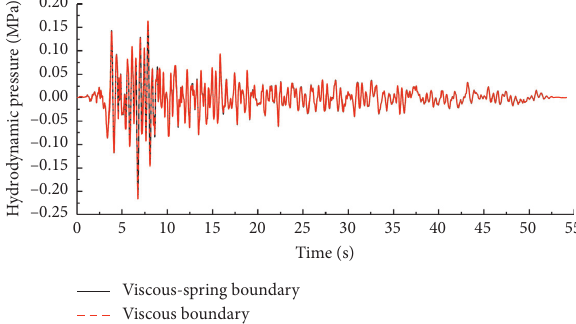
Figure 9: Time histories of relative horizontal displacements of dam crest and dam heel. Figure 10: Time histories of horizontal accelerations of the Pine Flat dam at dam crest.